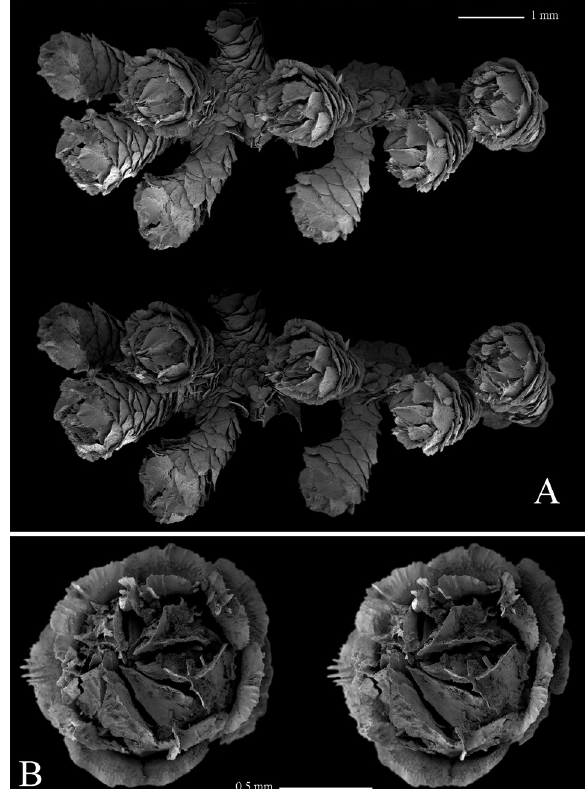
Fig . 11. – Thouarella grandiflora Kükenthal, 1912, holotype (MPUW 44): A, detail of branchlet, stereo pair; B, polyp on oral view, stereo pair.